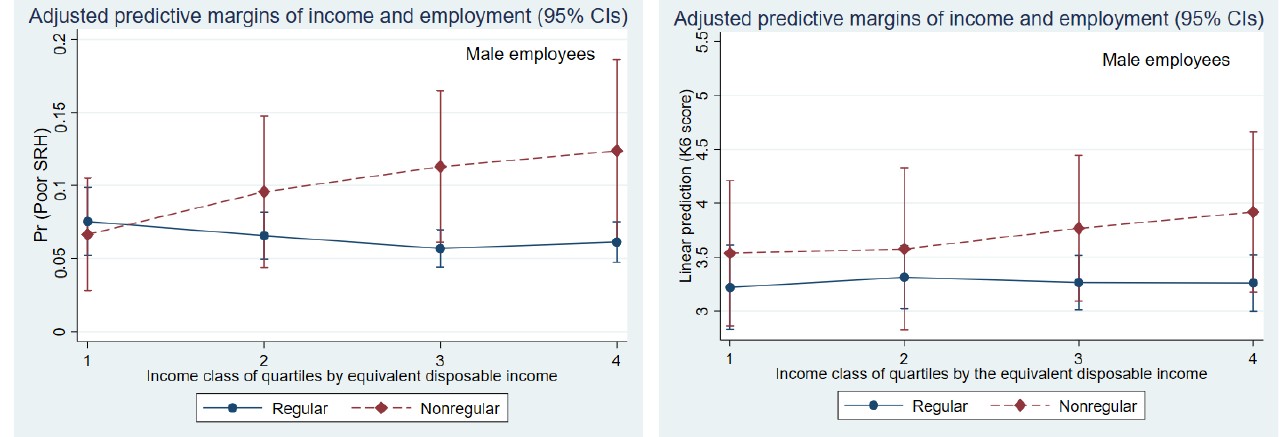
Figure 1. Association between economic status (equivalent disposable income quartile) and poor health (predicted self-rated health and K6 scores) by employment status in male workers.